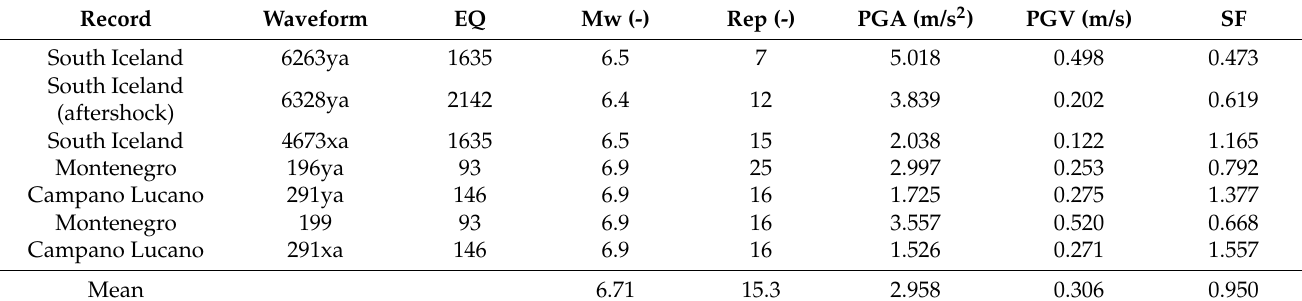
Table 3. Accelerograms dataset.